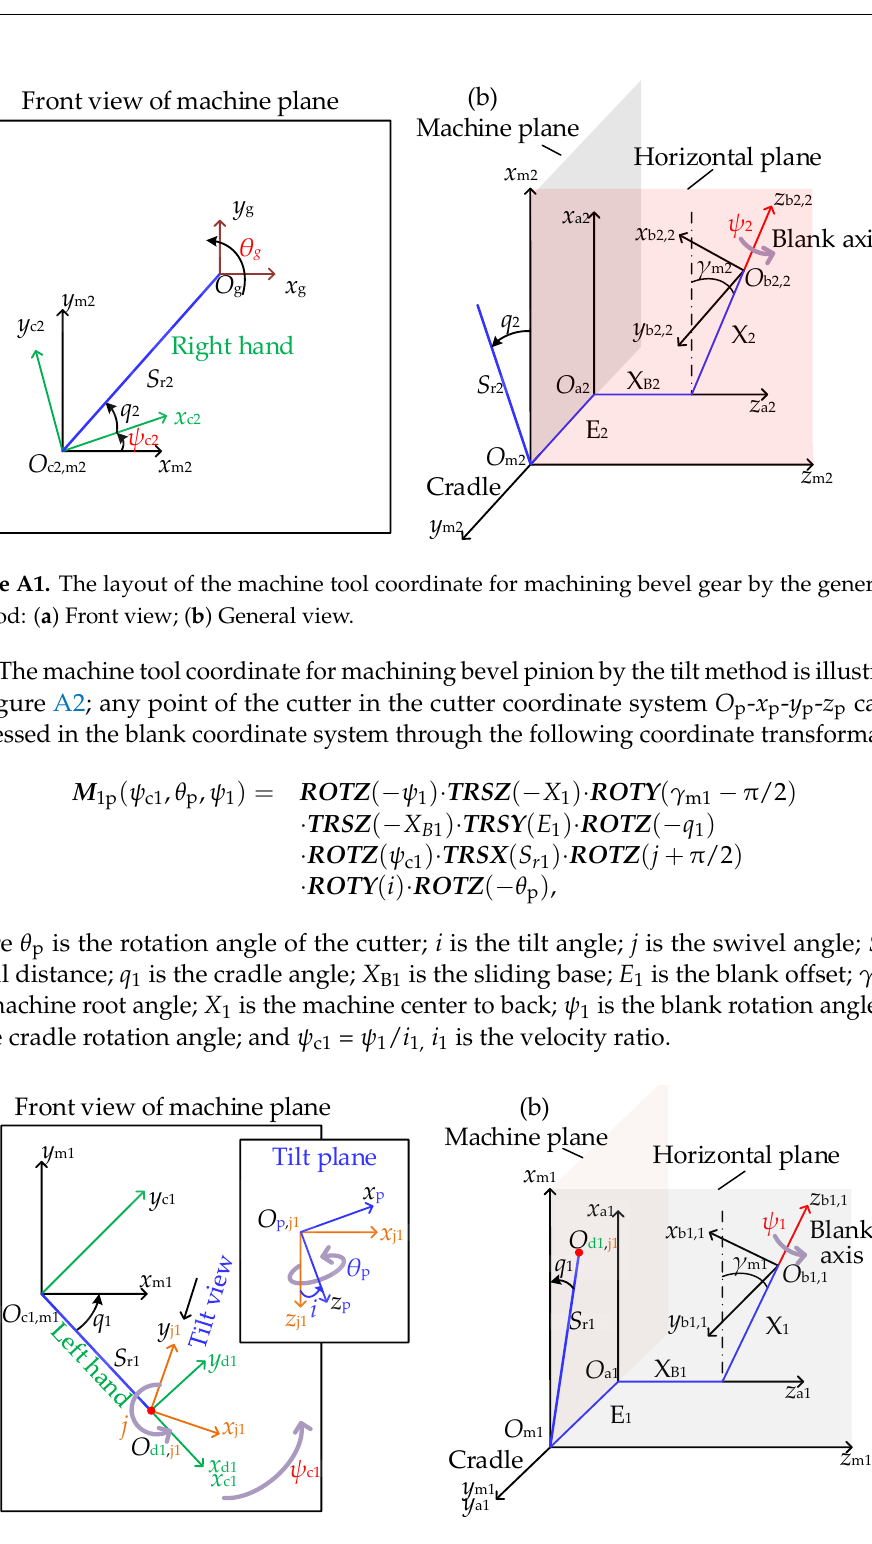
Figure A2. The layout of the machine tool coordinate for machining bevel pinion by the tilt method: ( a ) Front view; ( b ) General view. The schematic of the cutter is illustrated in Figure A3. The inner blade (IB) mills the convex side of the gear, and the outer blade (OB) mills the concave side of the